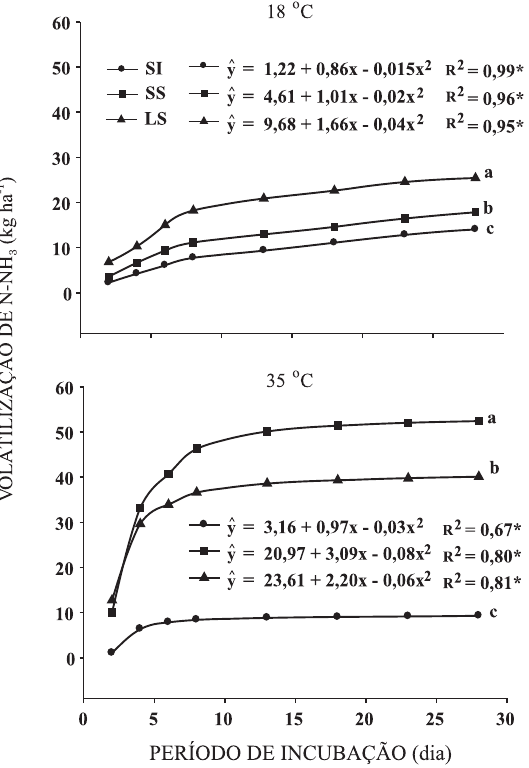
Figura 1. Volatilização acumulada de NH do solo ao 3 longo do tempo após a aplicação de ureia convencional ou de ureia com inibidor de urease nas formas sólida, com (SI) ou sem incorporação (SS), ou líquida sobre a superfície (LS), em ambiente mantido a 18 ou a 35 o C. Médias das duas fontes de N. Letras diferentes demonstram que houve diferenças entre as formas de aplicação do fertilizante. * Significativo (p <